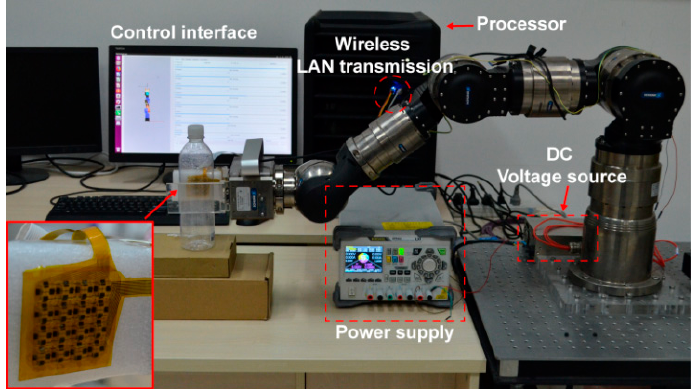
Figure 4. The robot grasping system and control interface.